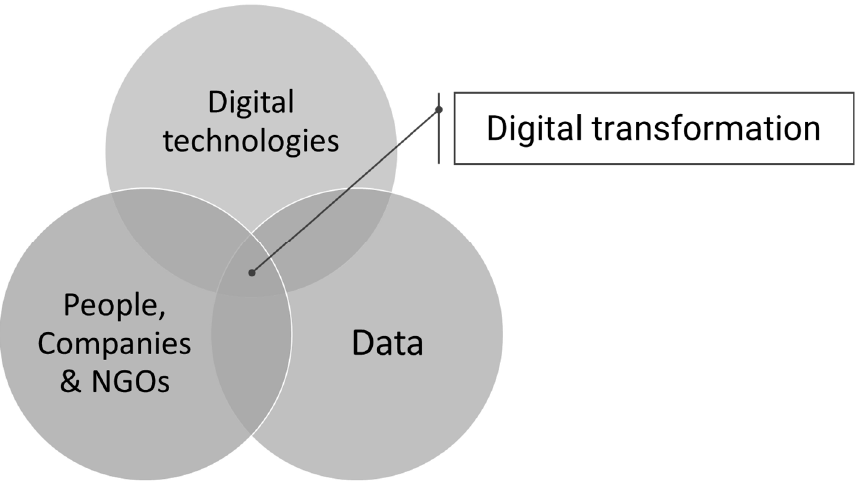
Figure 2. Components of digital transformation in the context of building smart cities. Source: proprietary compilation based on [ Error! Reference source not found. ].